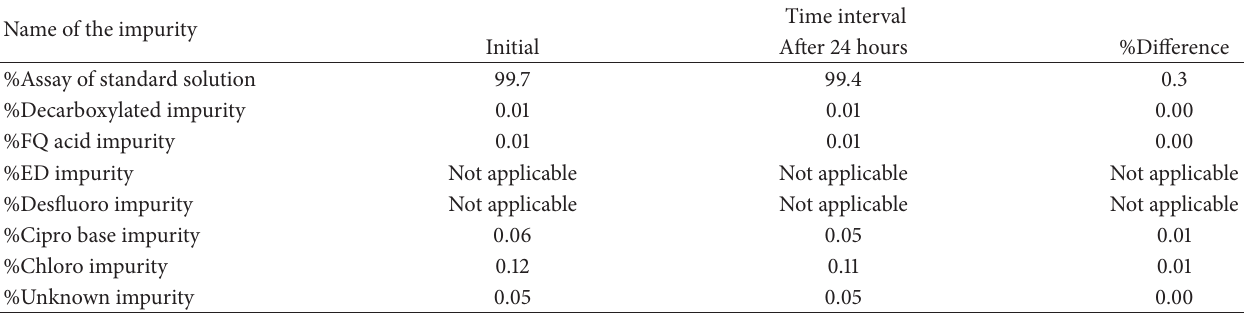
Table 11: Solution stability results of standard and control sample at room